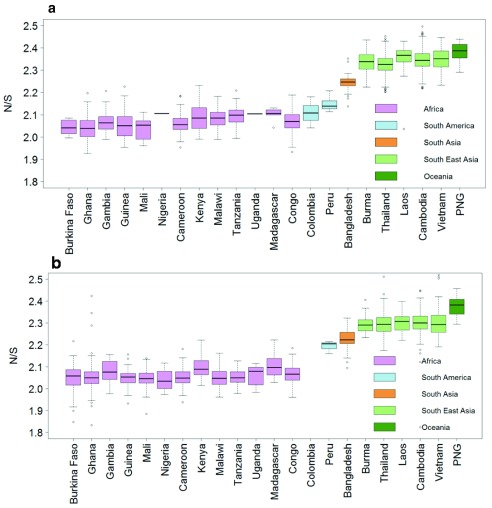
Higher ratio of non-synonymous to synonymous polymorphism in
P. falciparum samples from SEA when single strain and mixed strain samples are analysed separately..
A) Box-plot showing N/S for 1670 single strain samples. There was only one single strain sample each from Nigeria and Uganda.
B) Box-plot showing N/S for 1724 mixed strain samples. There were no mixed strain samples from Colombia. Mixed strain samples defined as samples with >10% SNP calls as heterozygous. This cut-off was determined from the distribution of heterozygous SNPs across the samples (
Supplementary Figure 3).